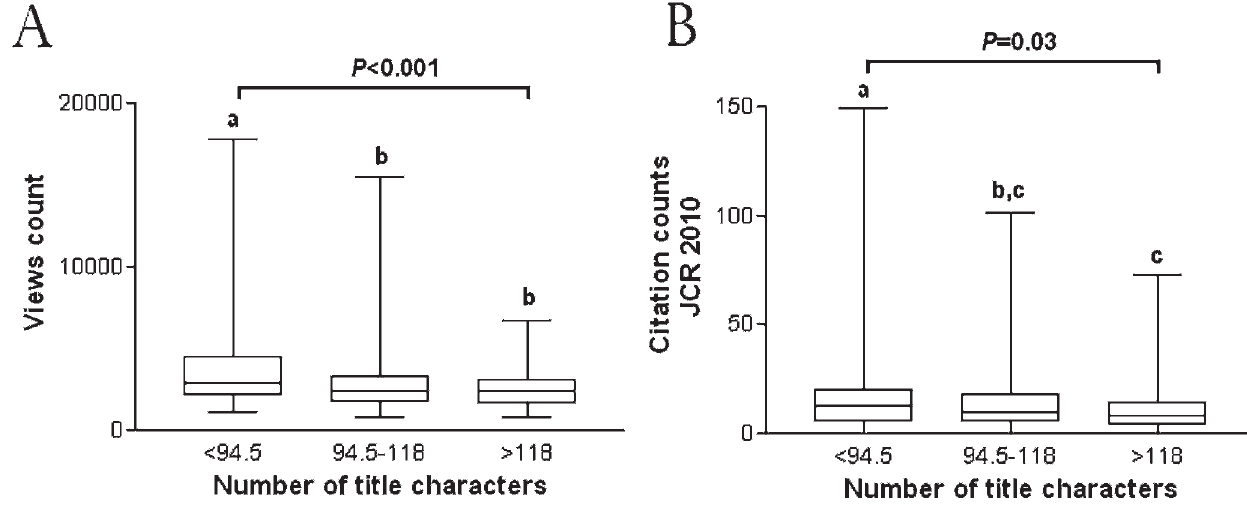
Figure 1 - View and citation counts according to the numbers of characters in the titles. A) The numbers of views were statistically different among the three groups analyzed ( p , 0.001). Post-hoc analyses showed that the group with the least number of characters ( # 94.5) had significantly higher view counts compared with the other two groups (94.5 to 118 and . 118) ( p , 0.01 for both). B) Citation counts were statistically significantly different among the three groups analyzed ( p =0.034). Post-hoc analyses showed that the group with the least number of characters ( # 94.5) had significantly higher view counts compared with the group with the greatest number of characters ( . 118) ( p , 0.05). Different letters (a, b, and c) designate statistically significant